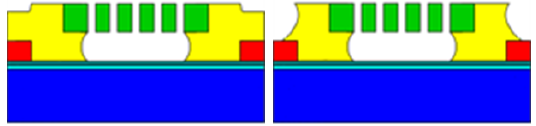
Figure 6. Cross section of the detector chip before (left) and after (right) the exposure of contact holes (Kallis et al.,